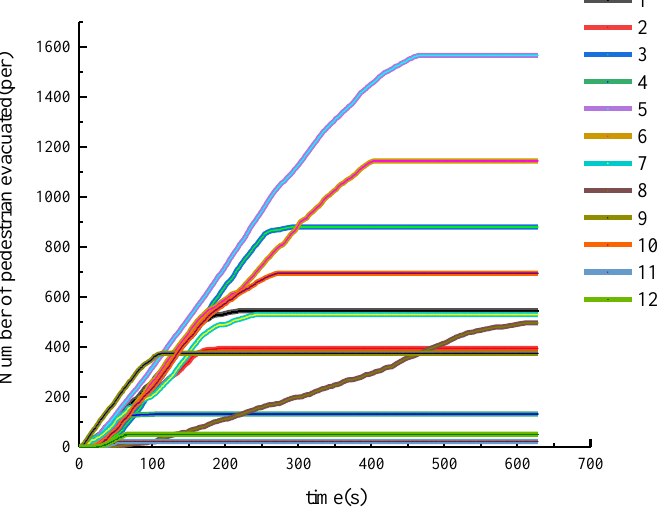
Figure 16. Number of pedestrians passing through each exit and travel time of sample 28.